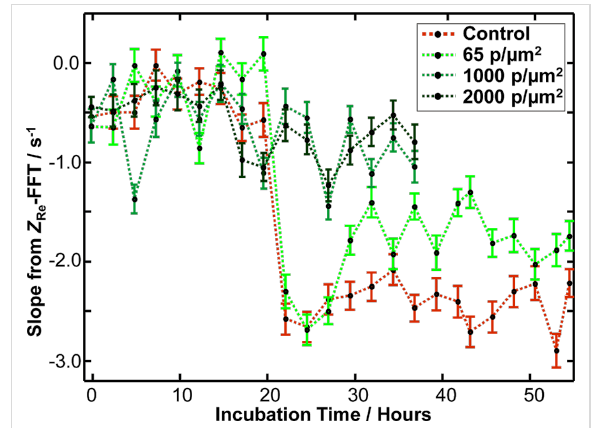
Figure 4: Slopes extracted from linear power spectral density regres- sion in the low frequency regime of power spectra originating from Z Re@4kHz impedance real part fluctuations for MDCK II cells seeded on CTAB nanorods with given densities at t = 20 h after nanoparticle seeding (green). Results for the untreated control consisting of cells growing on a bare substrate are displayed in red. Error bars indicate the standard deviation of the linear